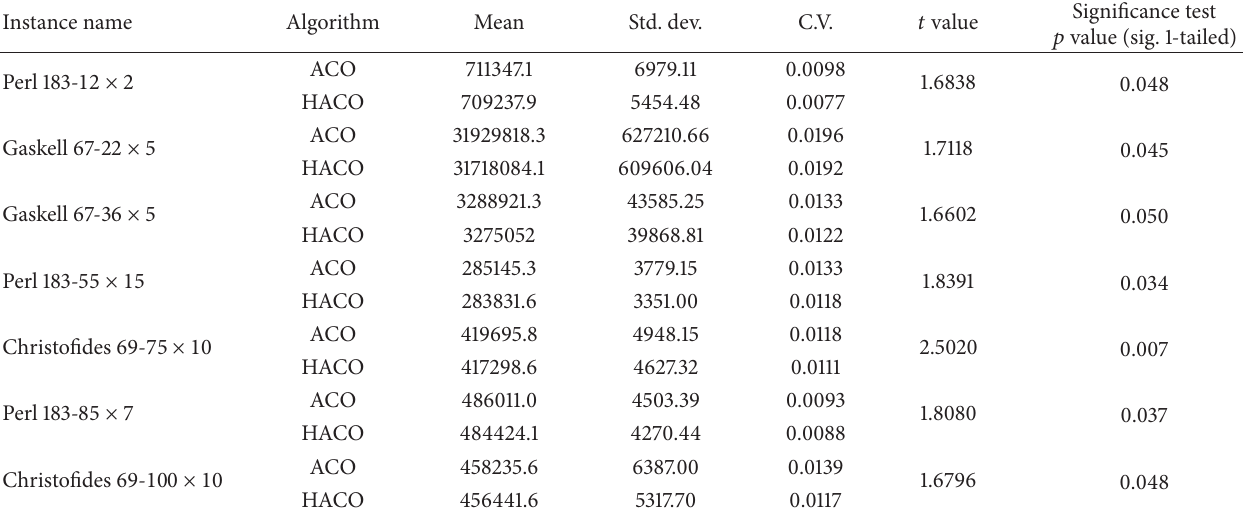
Table 9: Optimal objective function values of two algorithms (CNY).